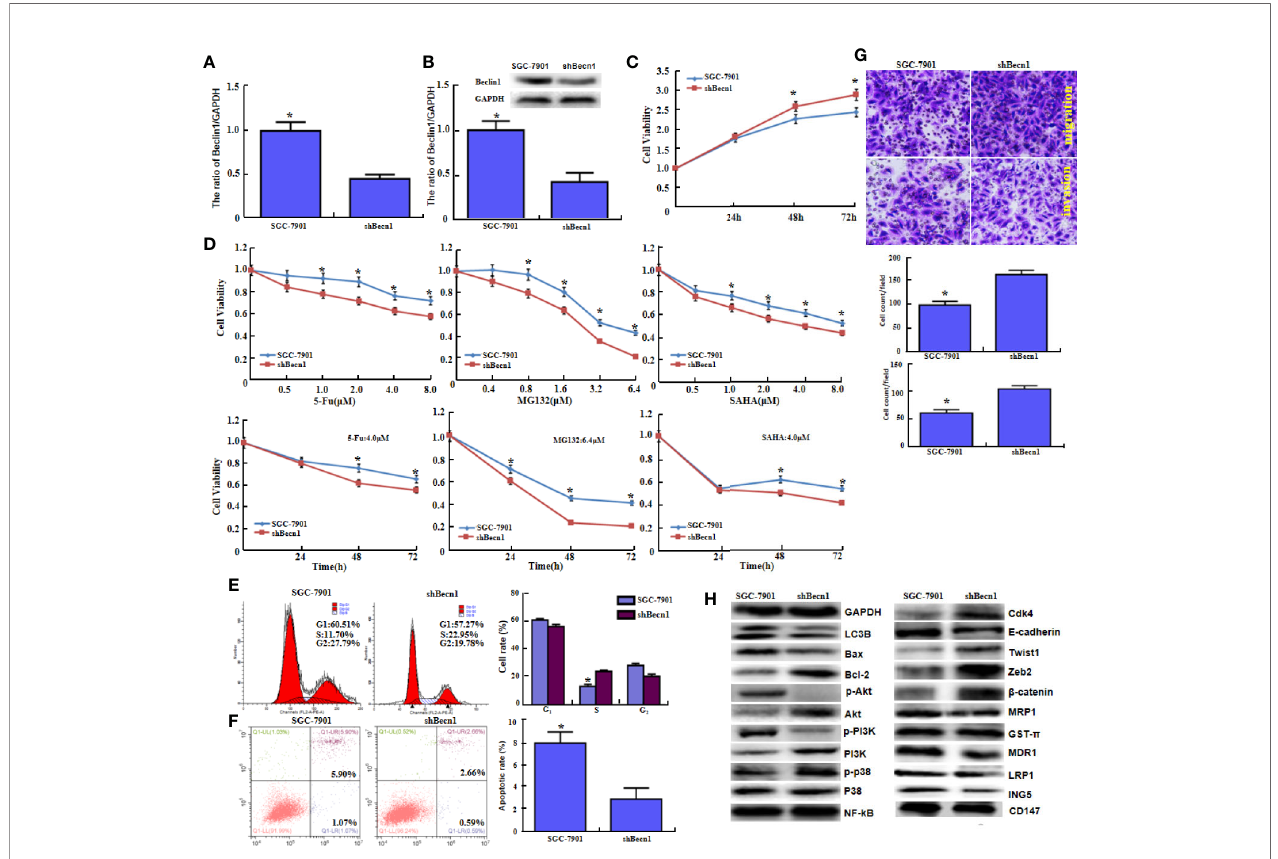
FIGURE 2 | The in vitro and in vivo effects of Beclin 1 silencing on aggressive phenotypes of gastric cancer cells. After transfection of shRNA- Becn1 , its expression became weak in SGC-7901 cells by real-time RT-PCR (A) and Western blot (B) . The cell viability was measured in SGC-7901 cells and their sh Becn1 transfectants using CCK-8 kit (C) , even treated with 5-FU, MG132, and SAHA (D) . Cell cycle and apoptosis were examined by propidium iodide (PI) (E) and Annexin-V (F) staining respectively. Both migration and invasion were determined in SGC-7901 and sh Becn1 transfectants by transwell chamber assay (G) . The phenotype-associated proteins were screened by Western lot (H) . * P < 0.05, compared with the